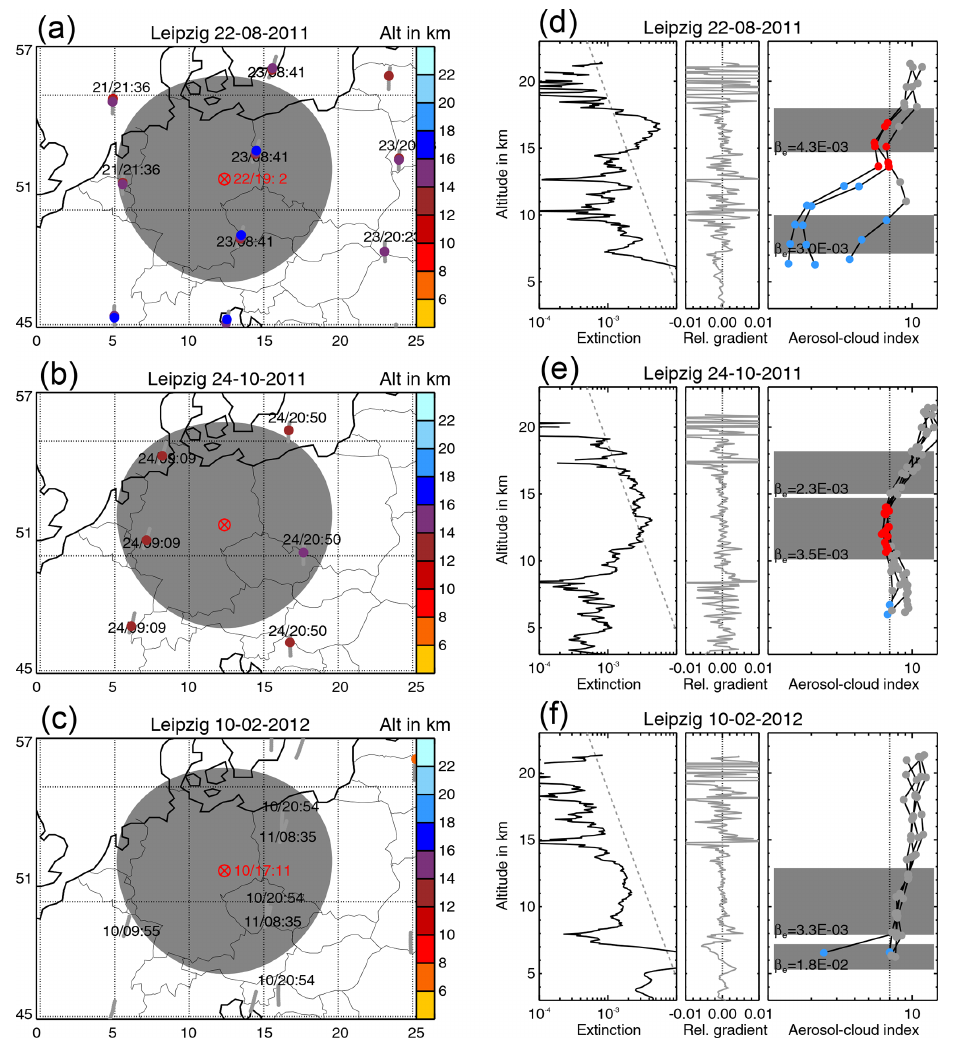
Figure 10. Nabro aerosol measured by the Leipzig lidar and MIPAS on (a, d) 22 August 2011, (b, e) 24 October 2011, and (c, f) 10 Febru- ary 2012. (a, b, c) The maps show the lidar station, lidar measurement time, match radius, MIPAS orbits, MIPAS profile measurement time, and MIPAS cloud top height (colour coded). (d, e, f) Left: Leipzig lidar extinction profile (black line) and the extinction coefficient threshold of 3 × 10 − 3 km − 1 at 18km (grey dashed line). Middle: the relative extinction gradient (grey line). Right: MIPAS ACI profiles within the match range. The grey dots denote clear air, red dots denote sulfate aerosol, and blue dots denote ice and optically thick clouds. The black dotted line is the ACI threshold of 7. The grey boxes indicate the cloud layers detected by the lidar and β e gives the average layer extinction.